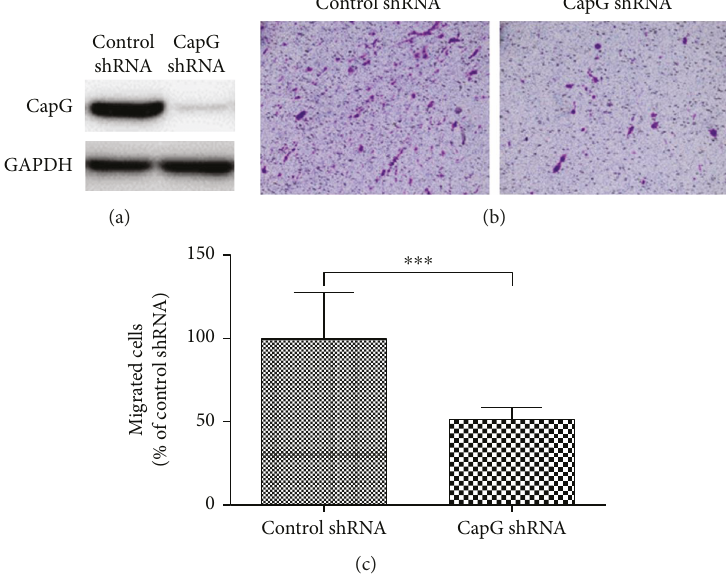
Figure 3: The ability of cellular migration was determined in HT29 cells. (a) A control shRNA and a CapG shRNA were transfected separately into HT29 cells, and the protein expression of CapG was determined by Western blotting. (b) A transwell migration assay was used to evaluate tumor migration ability in cells after 24 h chemoattractant with FBS. Invaded cells in the bottom chamber were stained with 2% crystal violet solution, and (c) the numbers were counted. ∗∗∗ p < 0 001